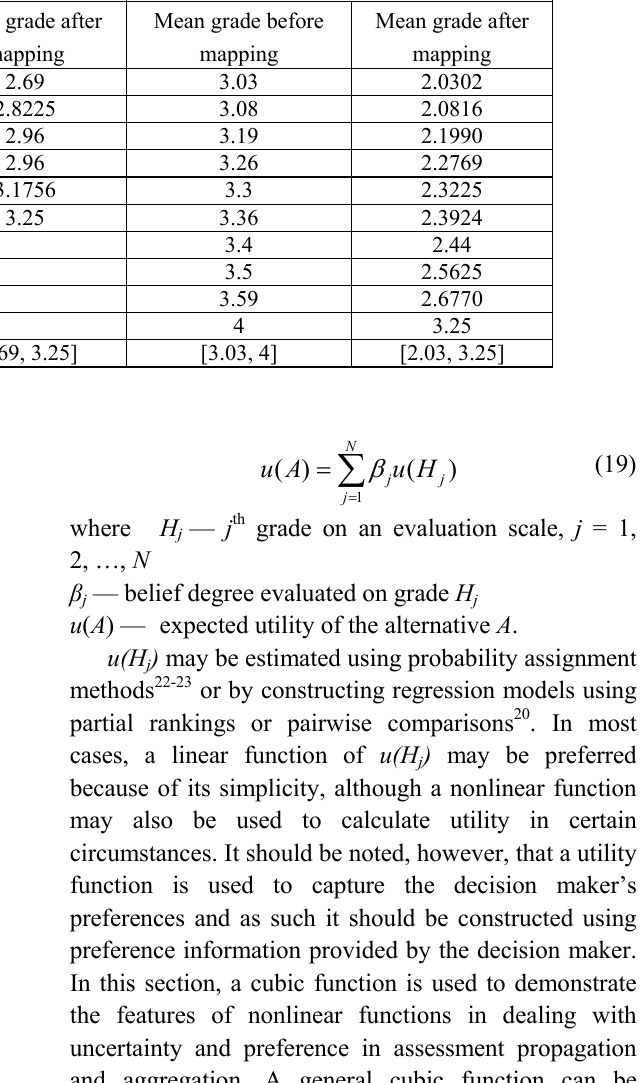
Table 8 Mean grade transformation using nonlinear mapping function Example 1 Example